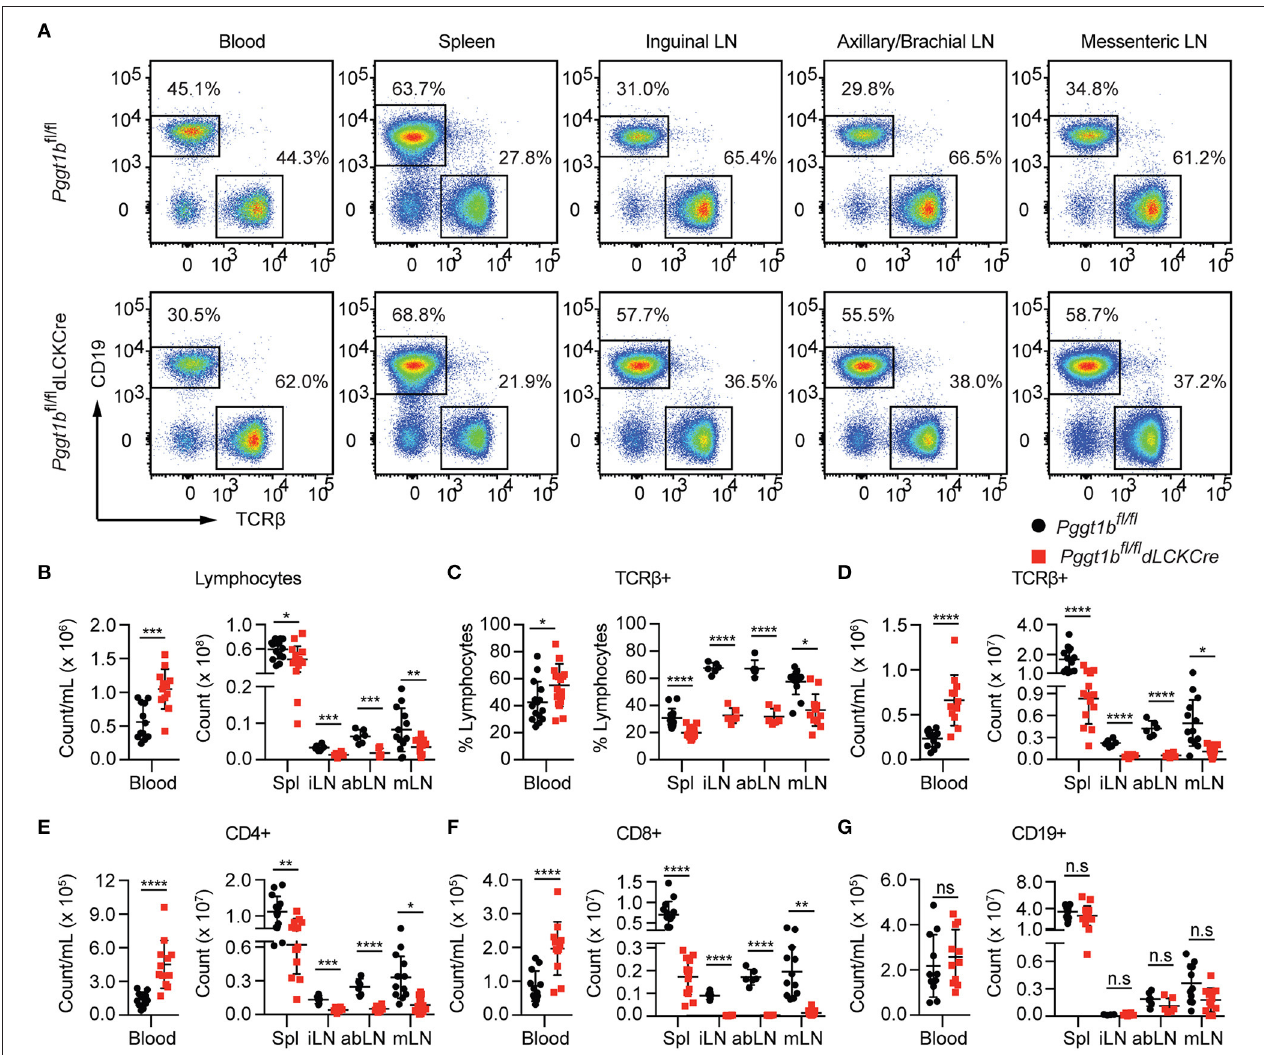
FIGURE 2 | T-Lympopenia in secondary lymphoid organs of Pggt1b fl / fl dLckCre mice (A) Flow cytometry analysis of CD19 and TCR β positive cells in the blood, spleen, and lymph nodes; (B–G) Total cell number of lymphocytes (B) ; Percentage (C) and number (D) of TCR β + cells; Total number of CD4 + (E) , CD8 + (F) , and CD19 + (G) cells in blood, spleen, and lymph nodes. Each dot represents a single mouse iLN, abLN, mLN: inguinal, axillary, and brachial, mesenteric lymph nodes, respectively (n.s. statistically not significant; * p < 0.05, ** p < 0.01, *** p < 0.001, **** p < 0.0001, unpaired t